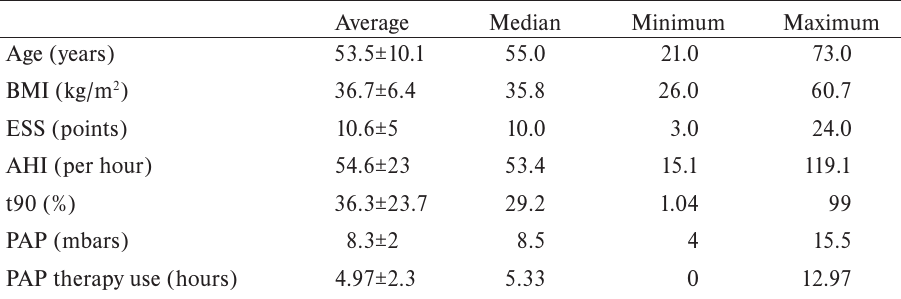
Table 1. Study group characteristics.